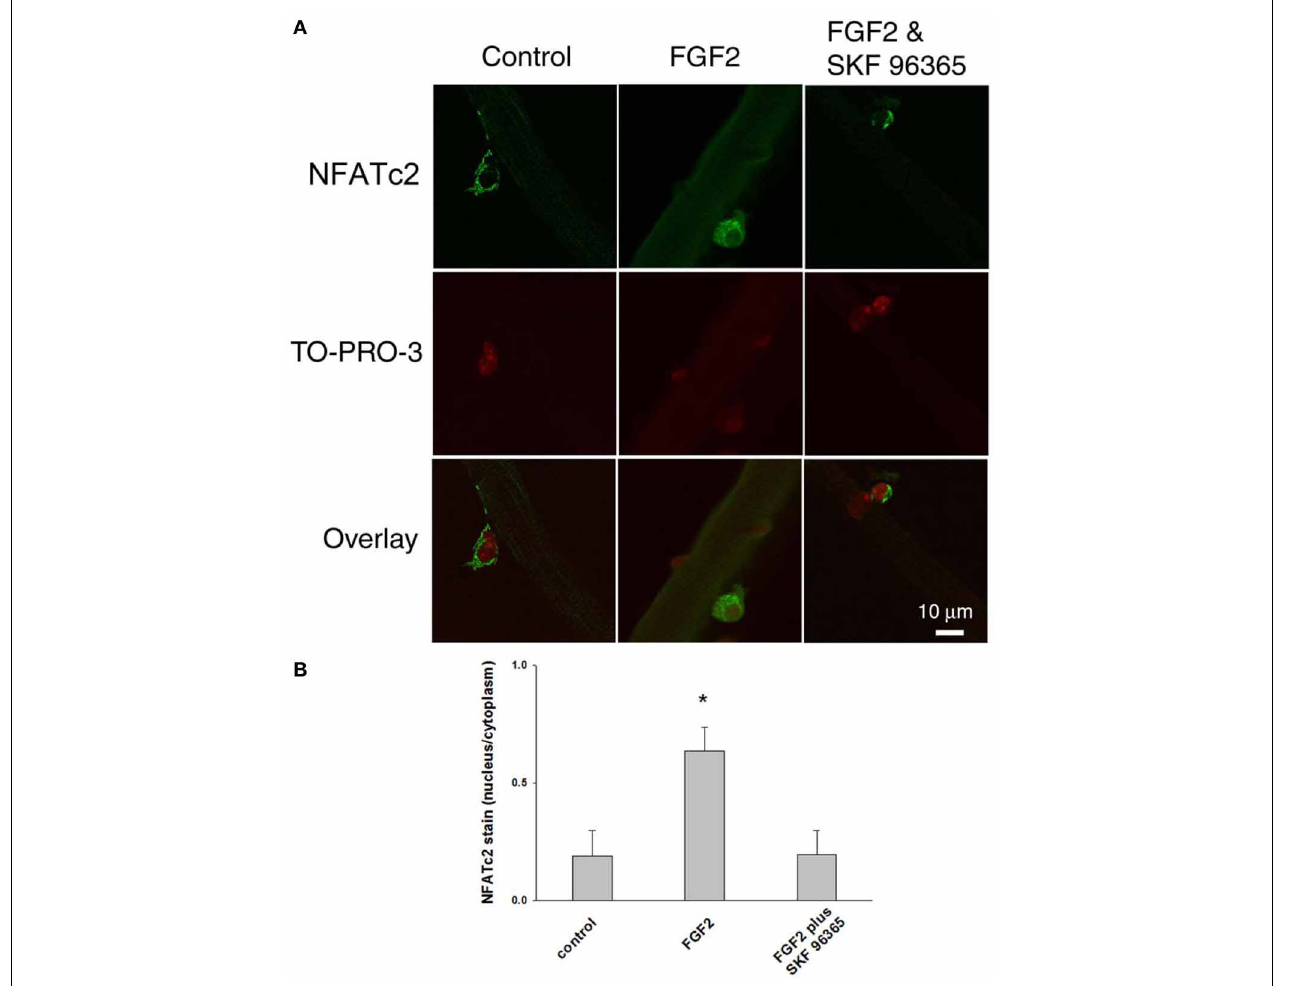
FIGURE 8 | FGF2 caused NFATc2 nuclear translocation. NFATc2 is not in the nucleus in the absence of FGF2 ( A,B ; left column). In the presence of FGF2, NFATc2 is located in both nucleus and cytoplasm ( A,B ; middle column). TRPC blocker SKF 96365 antagonized the NFATc2 nuclear